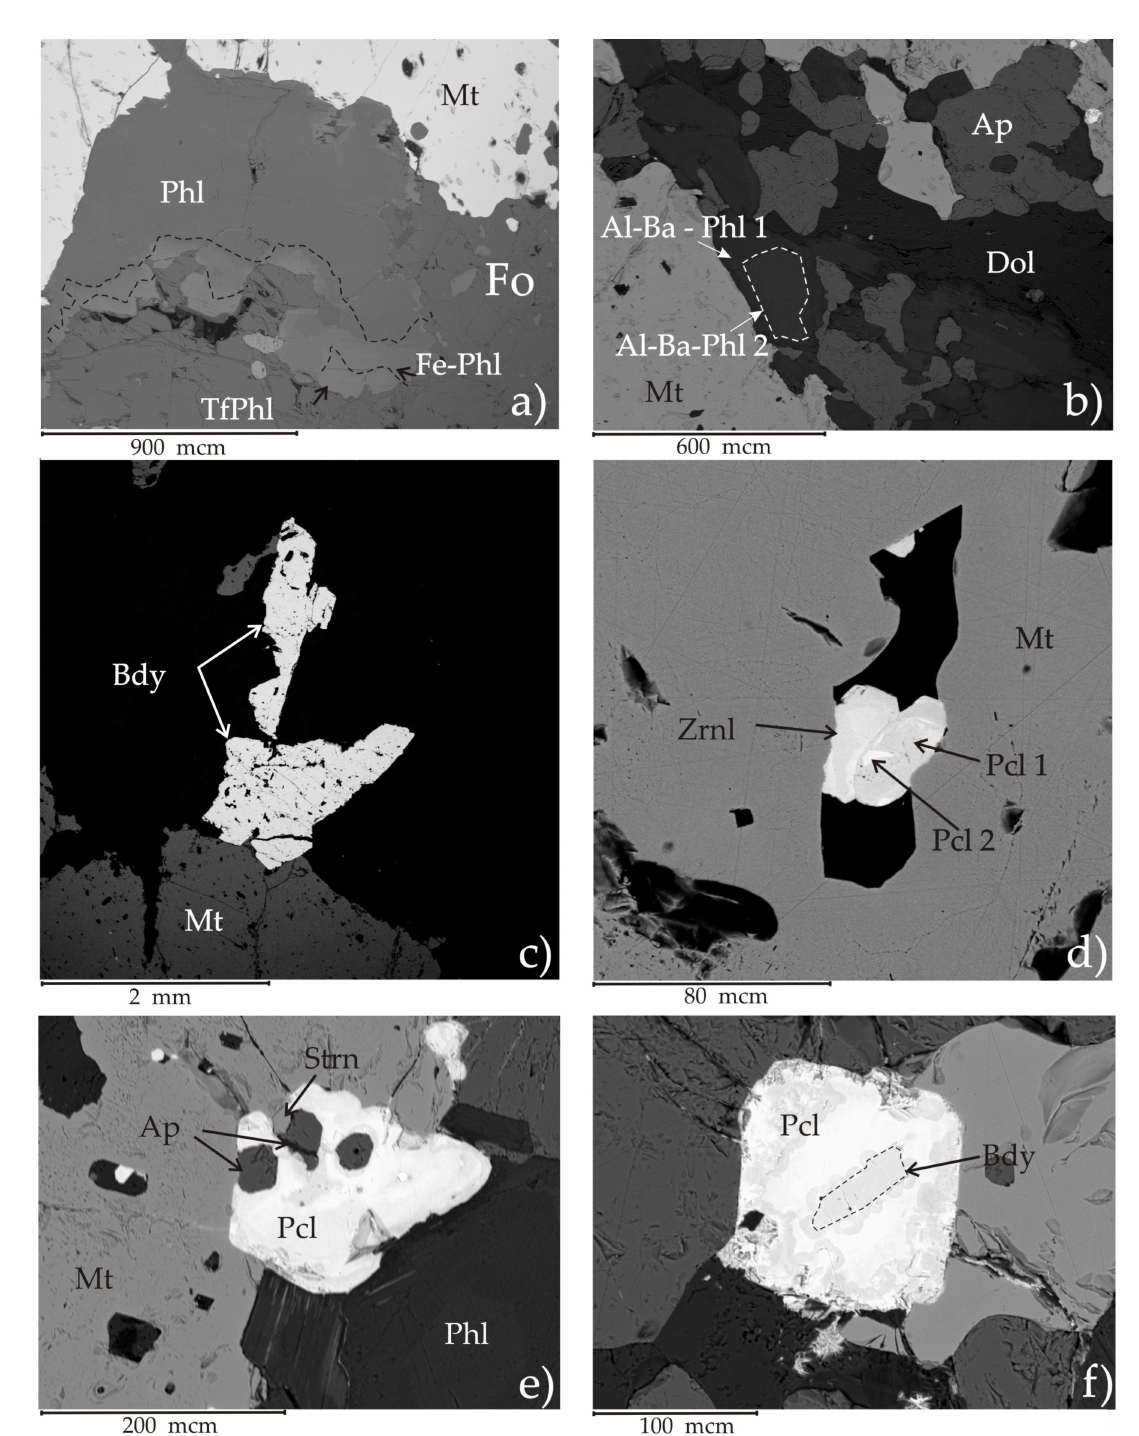
Figure 3. ( a ) The main grain of phlogopite (Phl) FOS 1, the edges of which pass into tetraferriflogopite (TfPhl) through the intermediate phase (Fe-Phl); ( b ) phlogopite FOS 2, the core of the grain is enriched in Ba (Al-Ba-Phl 1) compared to the edge (Al-Ba Phl 2), the whole grain is enriched in Al and Ba; ( c ) sub-idimorphic corroded grains of baddeleyite (Bdy) FOS 1; ( d ) the inclusion of zirconolite (Zrnl) and pyrochlore (Pcl 1 and Pcl 2) in magnetite FOS 1; ( e ) the inclusion of apatite and stronadelphite (Strn) in the pyrochlore (Pcl) grain FOS 2; ( f ) zonal pyrochlore grain (Pcl), in the core of which is the inclusion of baddeleyite (Bdy) FOS 2 (Mt—magnetite; Fo—forsterite; Ap—apatite;